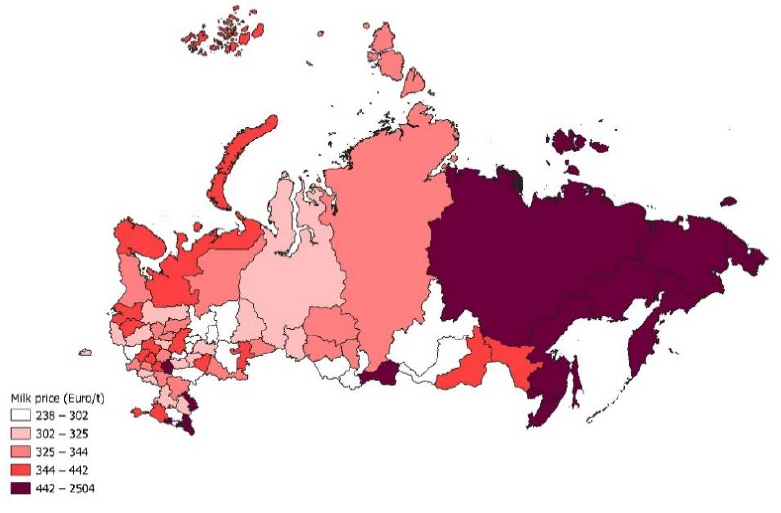
Figure 2. Map of milk prices in 2019 in Russia (Euro/t). Table 2. Moran’s I for spatial autocorrelation for milk prices in the period 2015–2019 in